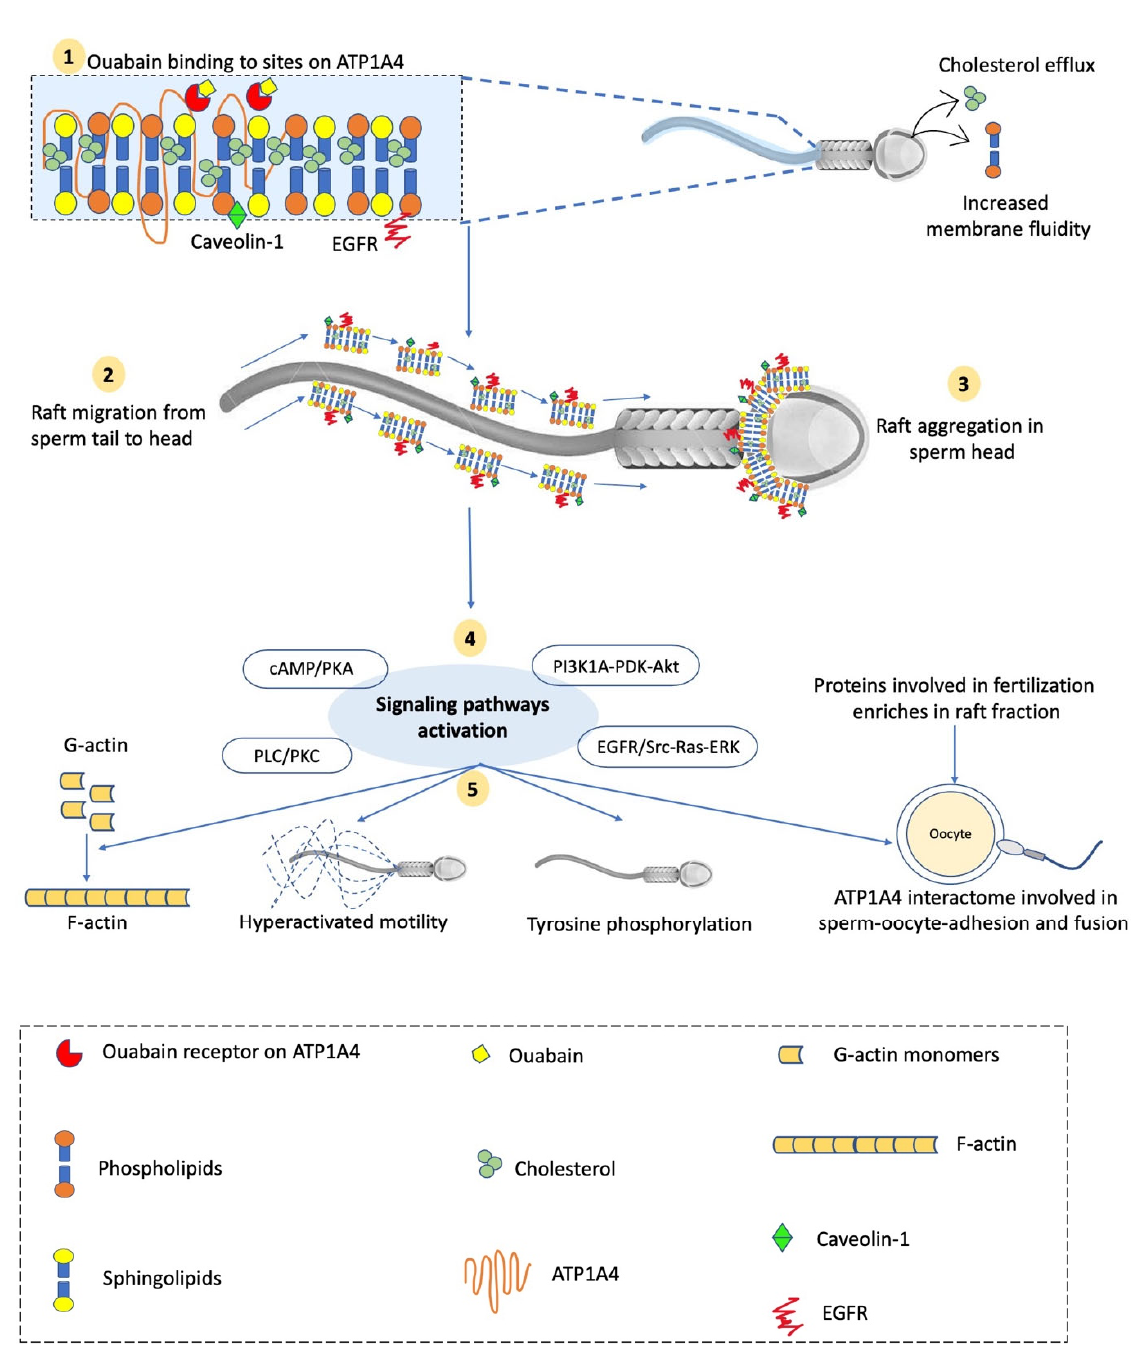
Figure 1. Schematic diagram of events during ouabain-induced signaling during bovine sperm capacitation. ( 1 ) Ouabain binding to its sites on ATP1A4 induces capacitation, where ATP1A4 interacts with caveolin-1 and EGFR in the raft fraction. ( 2 ) Simultaneous sperm surface alterations such as cholesterol efflux and increased membrane fluidity result in sequential raft migration from sperm tail to head. ( 3 ) Consequently, there is raft aggregation in the post ‐ acrosome and equatorial segment of the sperm head, enriching proteins involved in fertilization events and providing a platform for signaling molecules to activate downstream effects. ( 4 ) Various signaling pathways are activated and polymerize G ‐ actin to F ‐ actin with concomitant tyrosine phosphorylation of proteins and sperm hyperactivation. ( 5 ) ATP1A4 interactome on sperm surface interacts with zona pellucida to facilitate sperm–oocyte adhesion and fusion.